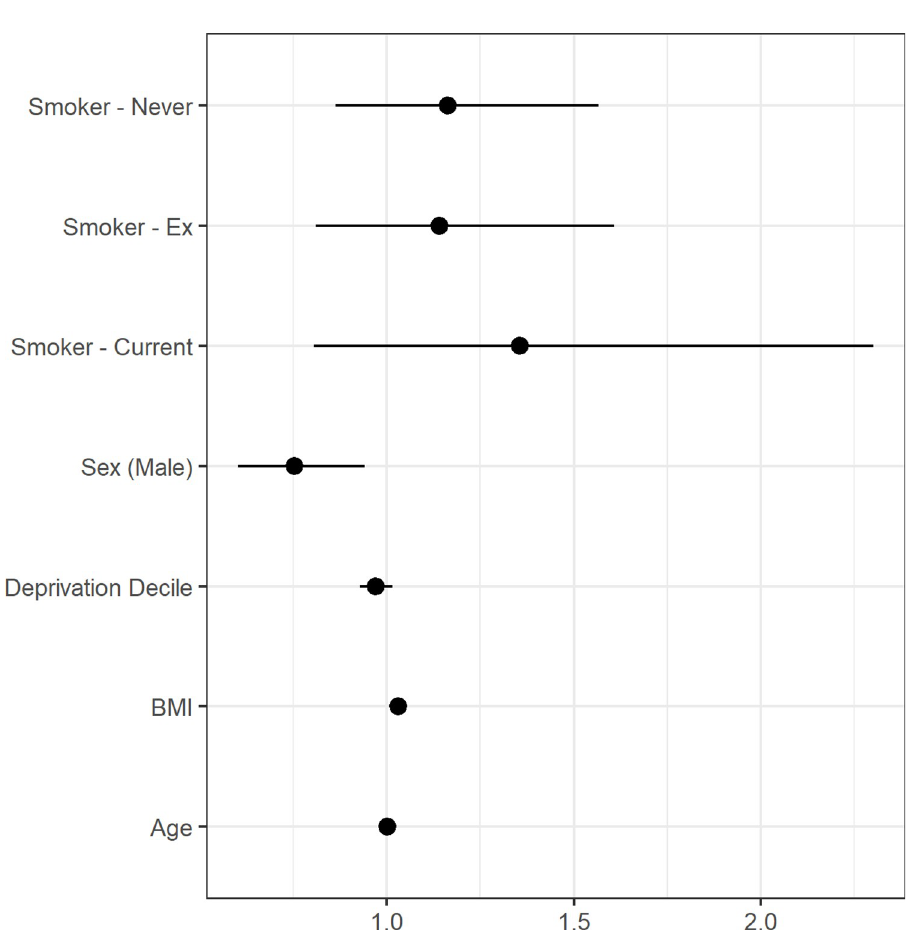
Fig 1. Multivariable regression model analyzing potential risk factors for post-COVID-19